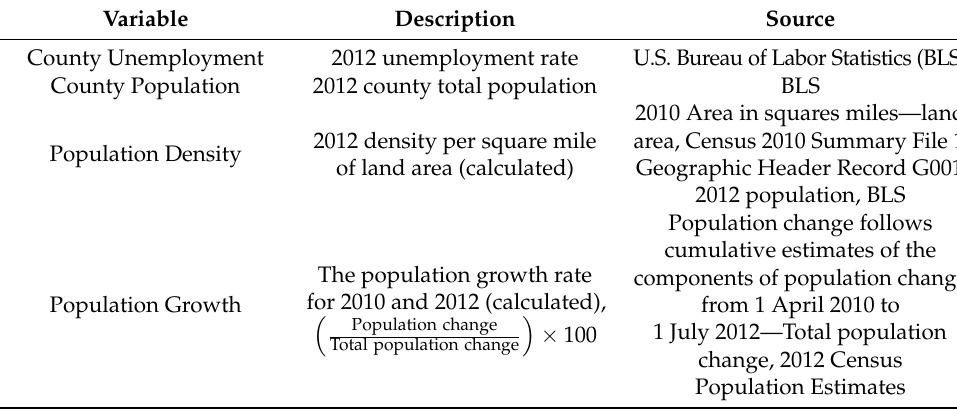
Table A6. County’s general